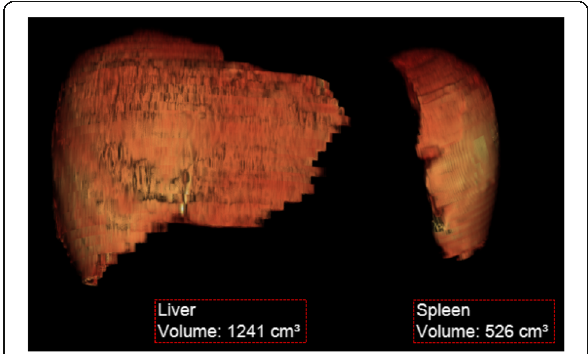
Fig. 1 Three-dimensional reconstructions of liver and spleen volumes from MRI in Gaucher disease. Volume-rendered organ volume reconstructions generated from non-contrast MRI data were used to track treatment response in a 9-year-old male with Gaucher disease. Organ volumes for the liver (1241 mL, 1.03 MN) and spleen (526 mL, 5.44 MN) are decreased from a prior examination at 6 years of age (1.35 MN and 6.43 MN,